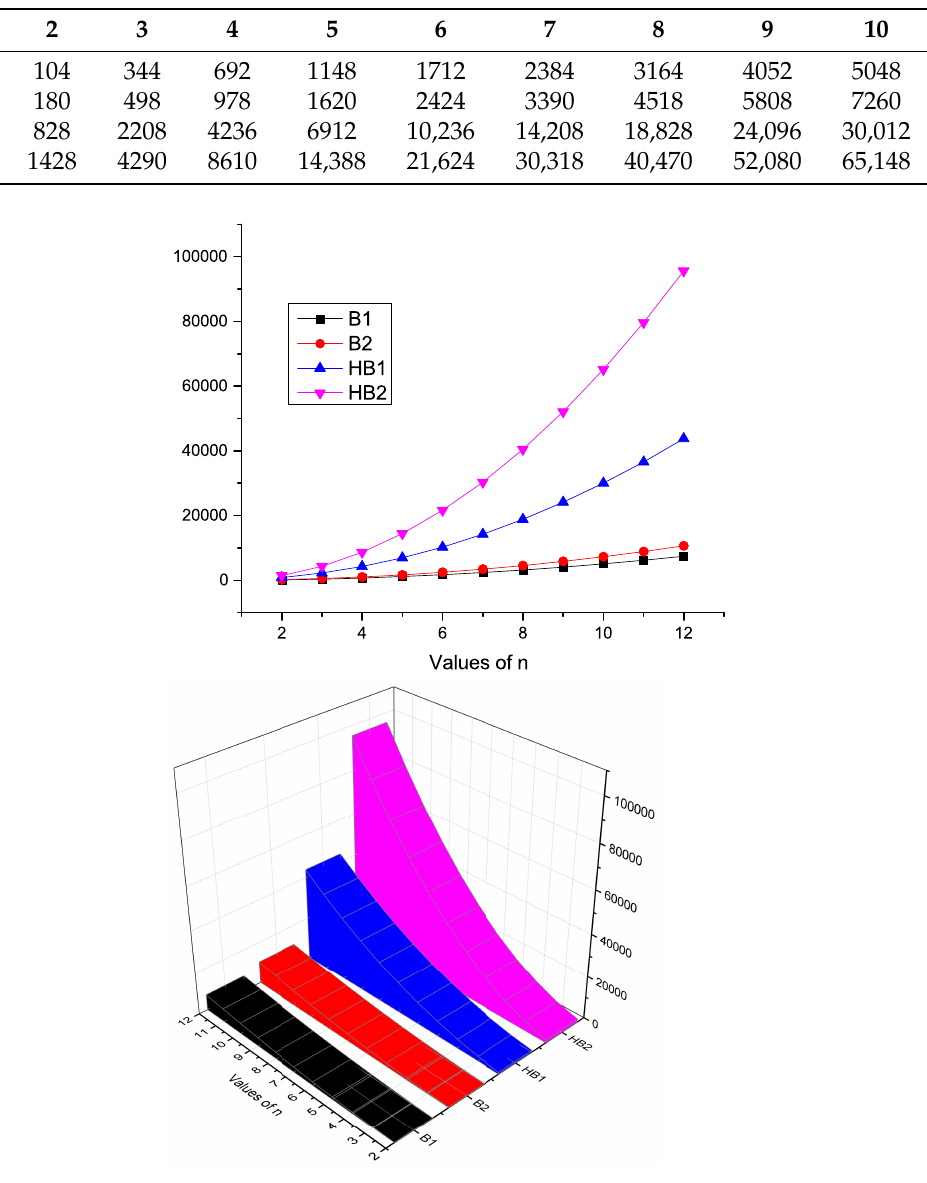
Figure 6. Graphical representation of K -Banhatti indices of HB n